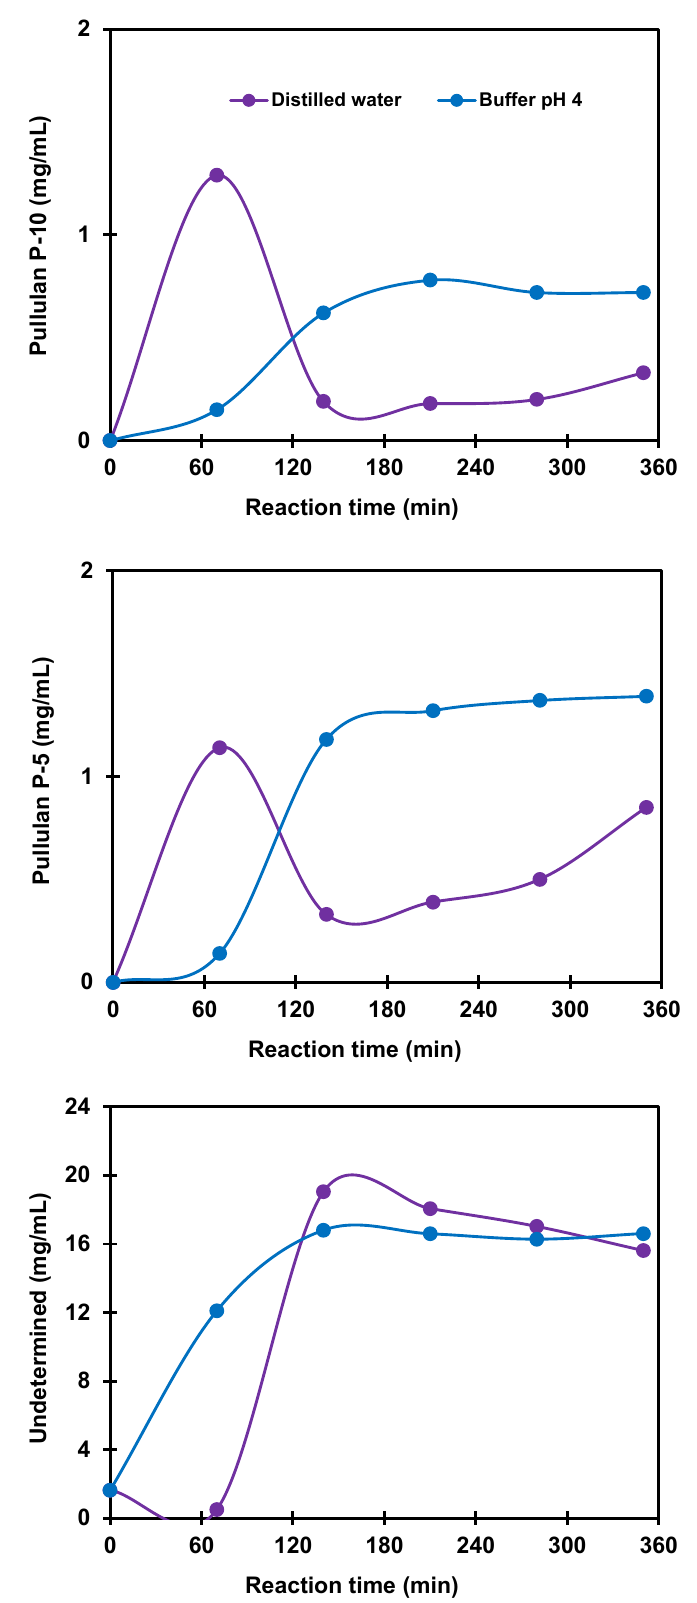
Figure 10. Effect of pH on the production of hydrolysates containing molecules associated with Pullulan standard molecular weights P-10, P-5, and undetermined but lower than P-5 at 40 ◦ C, 160 npun/g starch. Lines show trends.